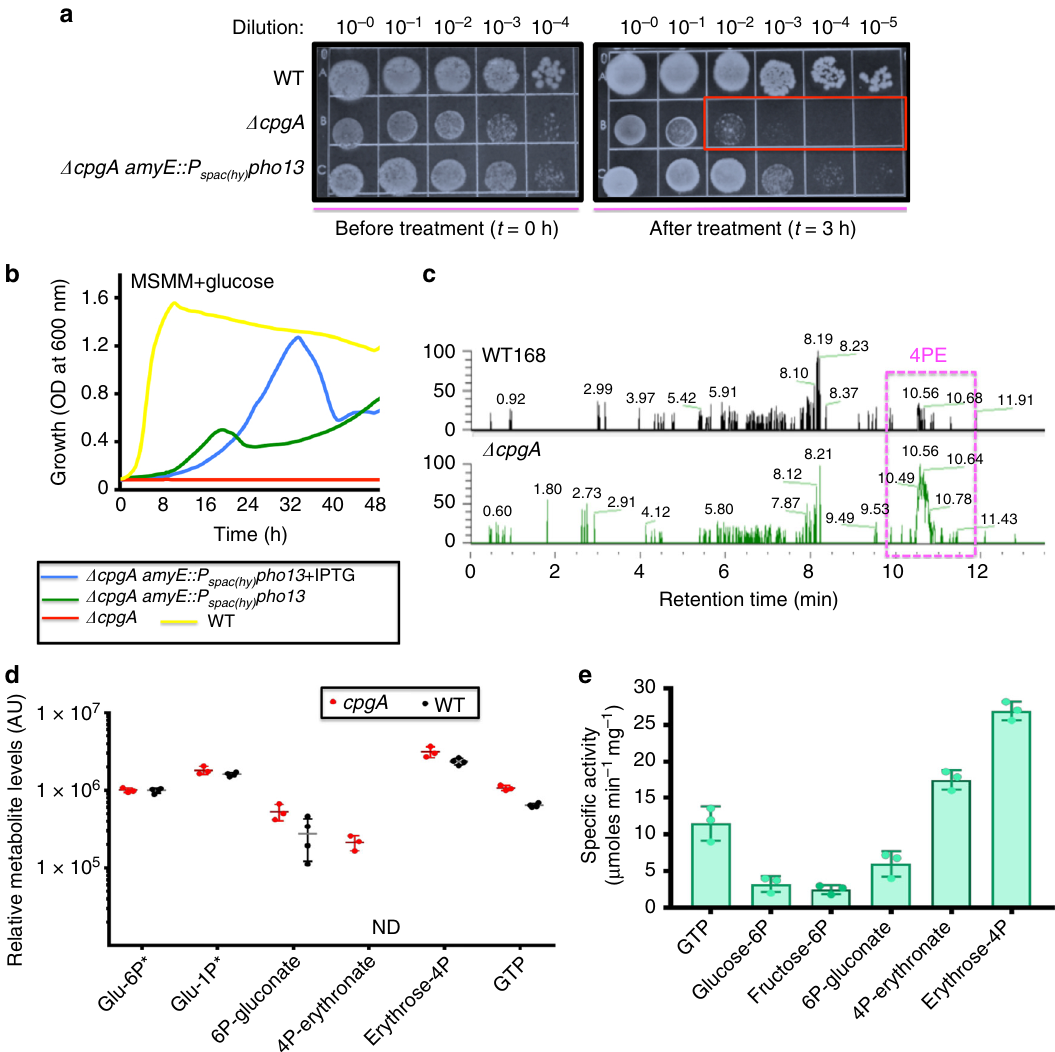
Fig. 5 Inhibition of 6PG dehydrogenase is due to 4PE. a Spot dilutions performed on LB medium to determine cell viability (CFUs) after exposure of cells growing in MSMM to 4%(w/v) gluconate for 0 min. (left panel) to 3 h (right panel) illustrating the >2 log reduction (red box) in Δ cpgA vs. Δ cpgA expressing the Pho13 phosphatase. b Growth monitored in MSMM with 0.8%(w/v) glucose is rescued in Δ cpgA cells ectopically expressing Pho13 with (blue line) and without 0.1 mM IPTG (green line). Growth trend of WT (yellow line) and Δ cpgA (red line) strains are also included for comparison. c Extracted Ion Chromatogram (EIC) for WT and Δ cpgA cells for mass of 4PE eluted from retention time of 0 – 12 min. d Intracellular metabolite levels (mean ± standard error of mean of normalized ion counts for n = 4 of independent biological replicates for mutant group, and n = 3 biological independent replicates for WT group) in WT and Δ cpgA cells as measured 30 min after shift of cells into MSMM medium with 0.8%(w/v) glucose. ND represents non- detectable levels of 4PE in WT. Origin for y-axis is set at 10 4 representing levels at least 10-fold above the detection limit. e In vitro phosphatase activity of puri fi ed CpgA with different substrates was measured using a malachite green assay ( n =